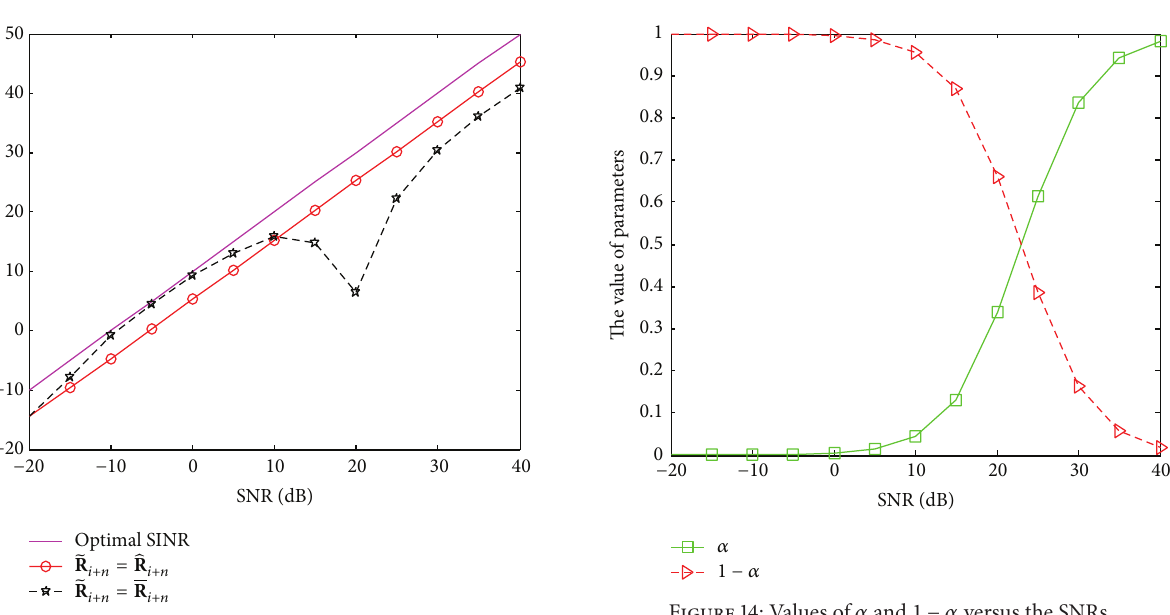
Figure 13: Output SINR versus the input SNR with different recon- structed IPN matrixes.